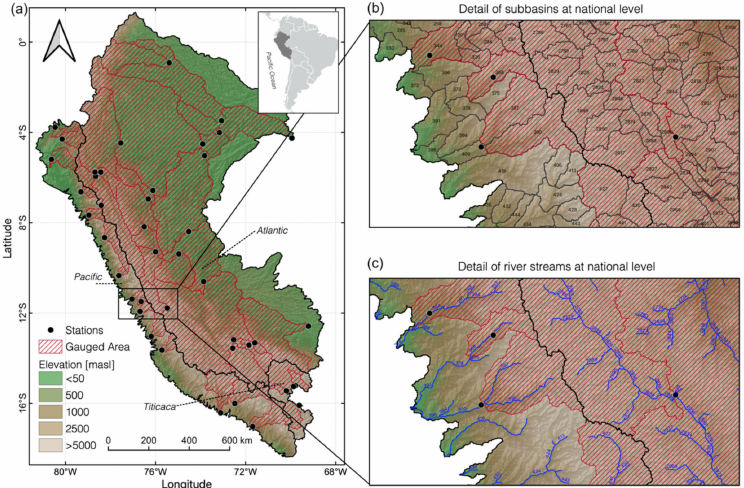
Figure 1. ( a ) Study area and hydrometric stations in the Pacific, Titicaca, and Atlantic slopes. De- tail of ( b ) sub-basins and ( c ) river streams used for the semi-distributed hydrological model at a national